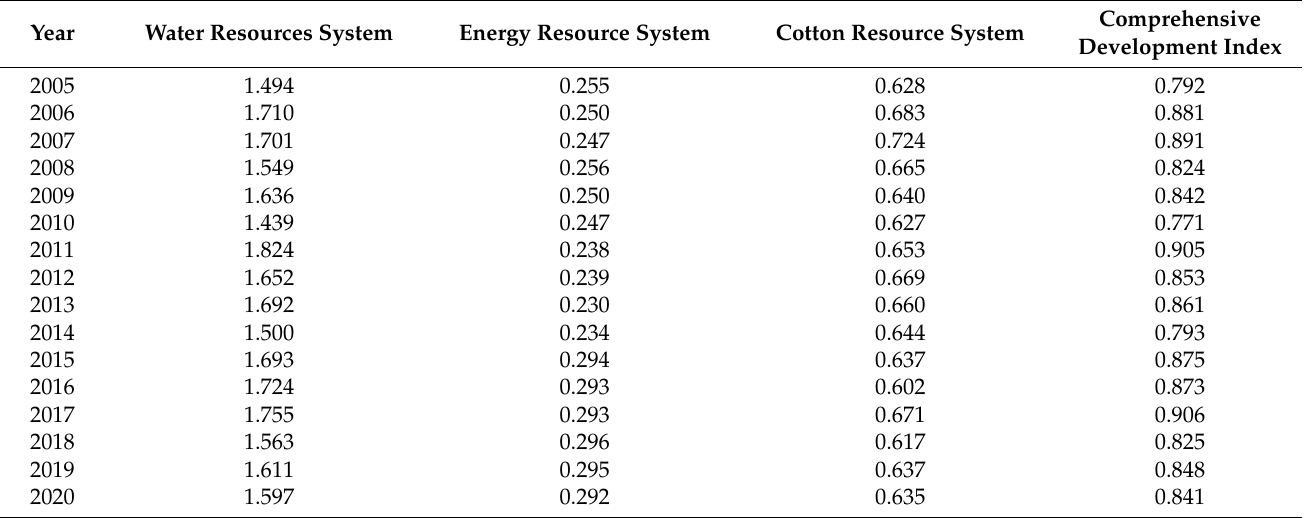
Table 3. System evaluation index of water resources, energy and cotton systems in Tarim River Basin from 2005 to 2020.